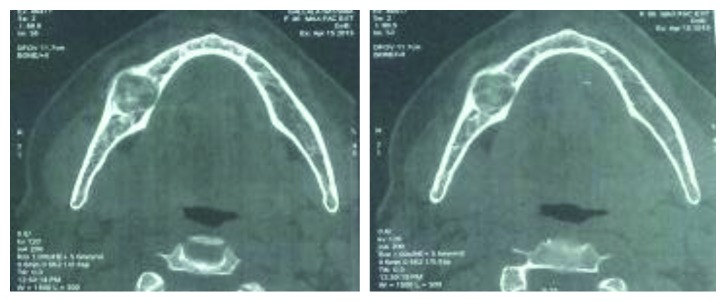
Computed tomography scan: axial views showing multiloculated ground-glass ossification of the lesion.